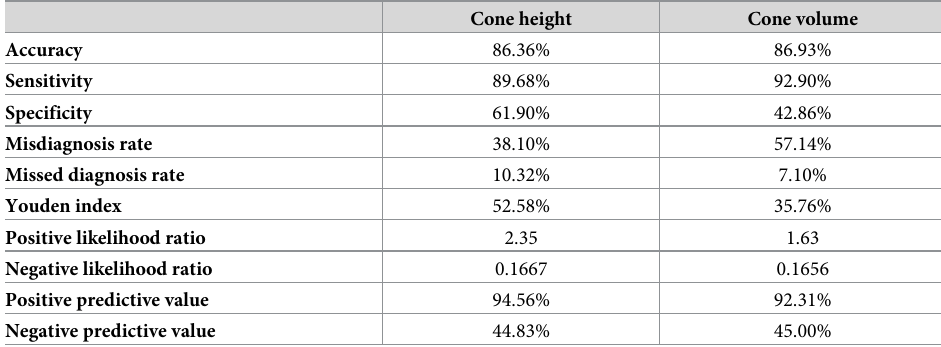
Table 8. Evaluation of the prediction of preterm delivery by cone height and